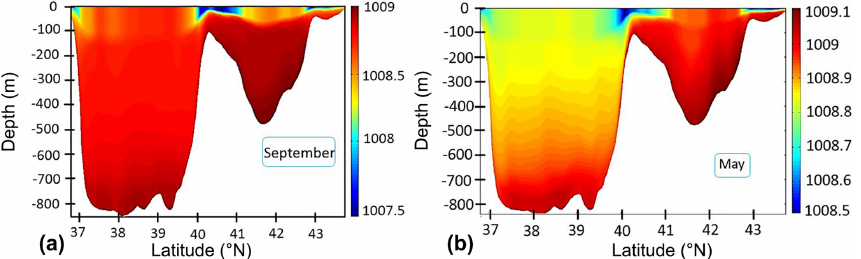
Figure 8. Cross sections (north–south) of the mean density obtained from model simulation during September (a) and May (b)